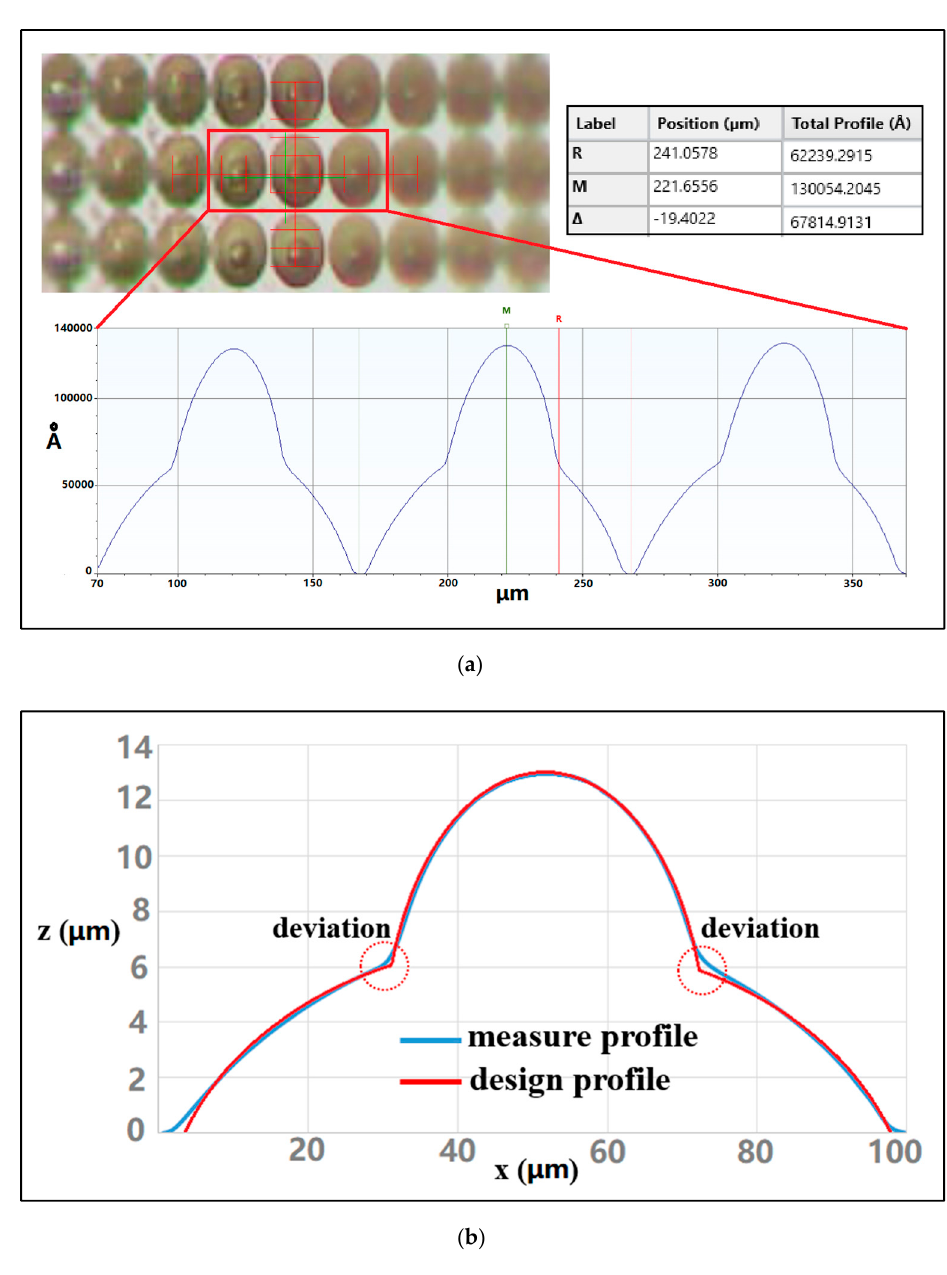
Figure 7. Cross-sectional profiles of the MLLA. ( a ) Cross-sectional profiles of the MLLA. ( b ) Comparison of the designed and measured cross-sectional profiles of the MLLA. To verify the image quality of the MLLA, an experiment is carried out, as shown in Figure 8. A mask with letter “A” is put between the light source of the microscope and the MLLA, and images are observed by a CCD camera, which is equipped on the